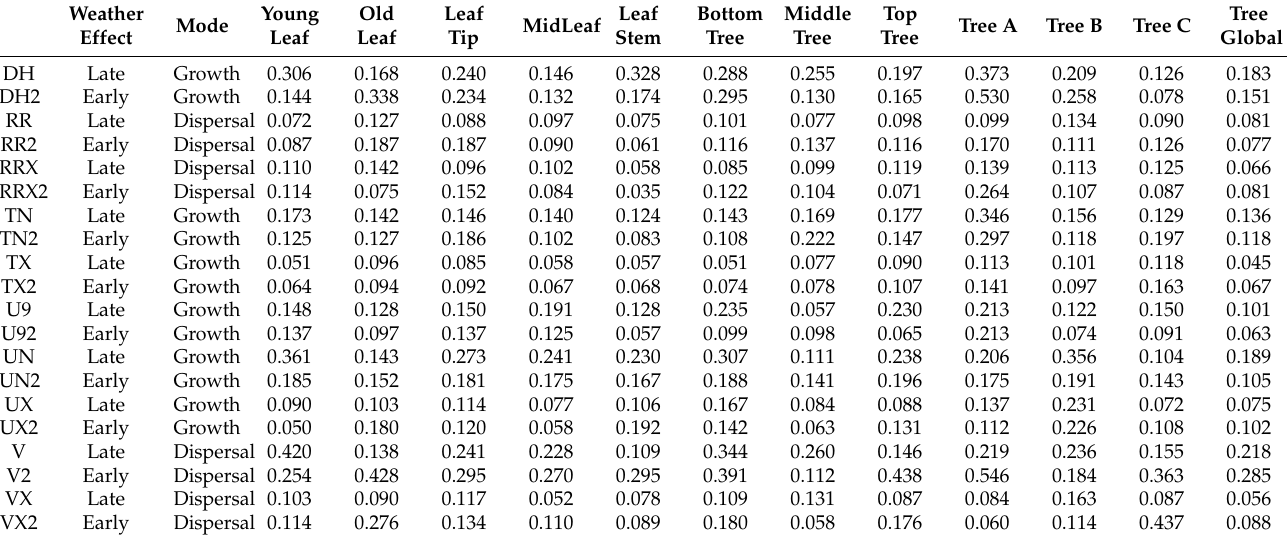
Figure 2. Rank analysis of covariate impact on prevalence in the random forest, example from fitting general prevalence of Colletotrichum on all sample trees (last column of Table 2). Meteorological covariates are ranked by average increase in node purity in tree models from the forest, i.e., its impact on variance at the node. Covariates with a 2 in their names are reflecting weather conditions from the week preceding the prevalence estimate, while those without are weather conditions from the same week as the prevalence estimate. Table 2. Variable importance for meteorological factors as extracted from the different random forest models, and their classification as early or late, and mode of impact on fungal life cycle. Values indicate average increase in node purity of the factor in the test model, i.e., its average impact in predicting fungal